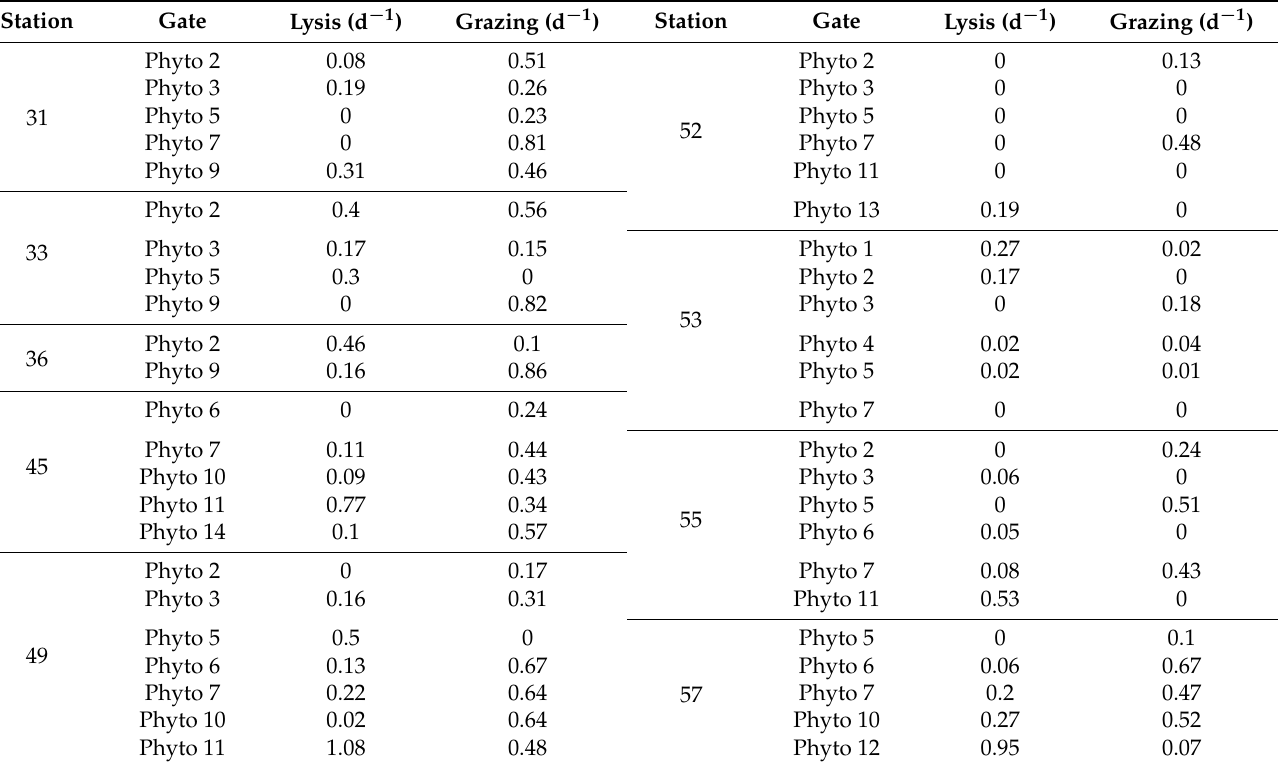
Table 5. Specific viral lysis and microzooplankton grazing rates (d − 1 ) for the different phytoplankton populations in the Amundsen Sea. Stations 31–45 were located within the ASP, stations 55 and 57 near the GIS, and the other stations are located at the